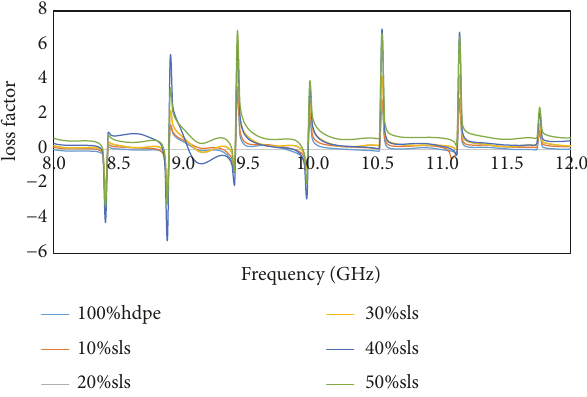
Figure 3: XRD spectrum of 100%HDPE and SLS-HDPE compos- ites.